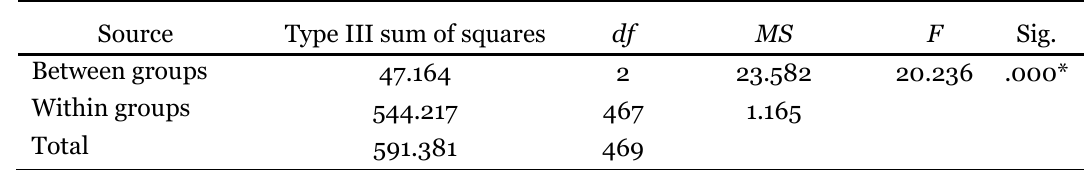
One-Way ANOVA of Parents’ Perceptions Toward the Distance Learning Process According to Child’s Grade